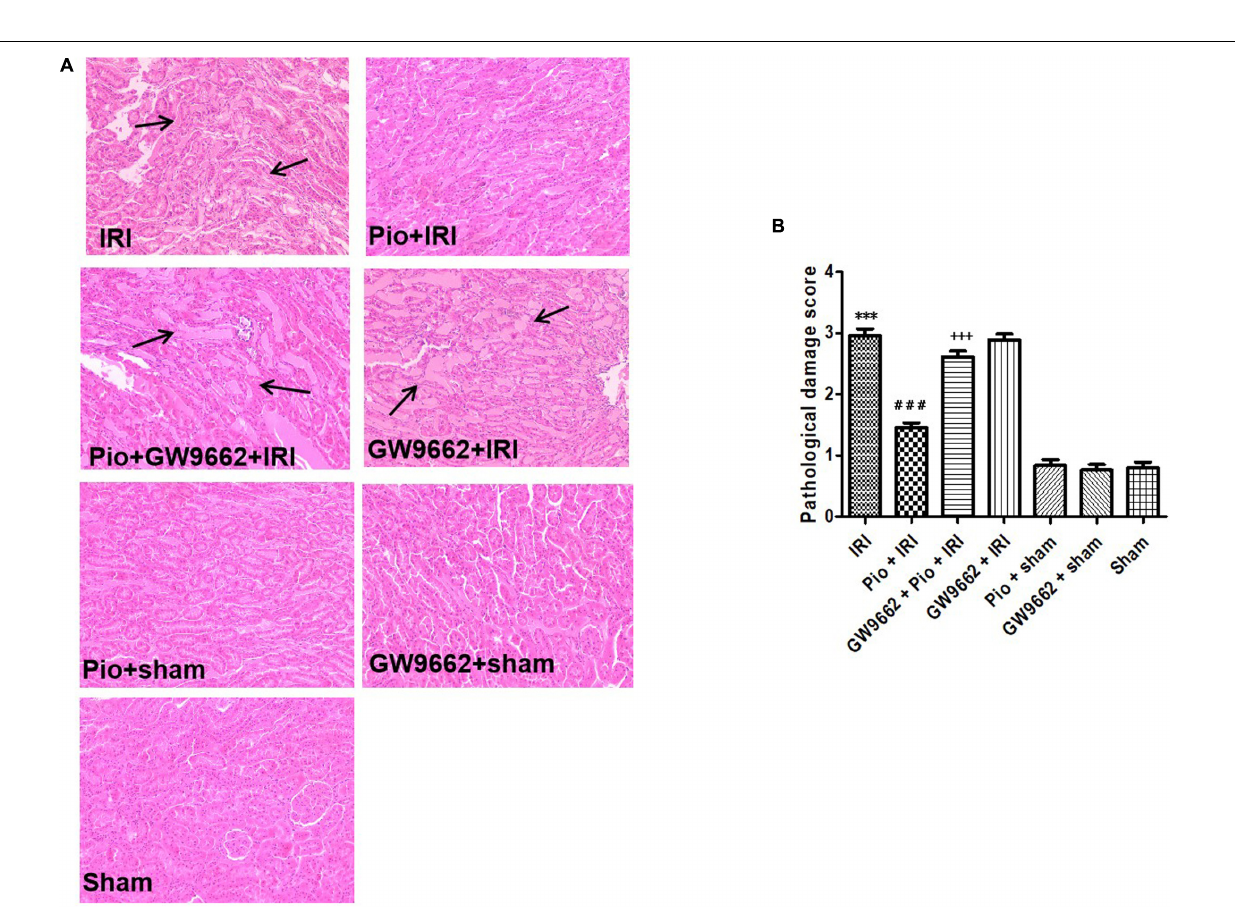
Frontiers in Physiology |